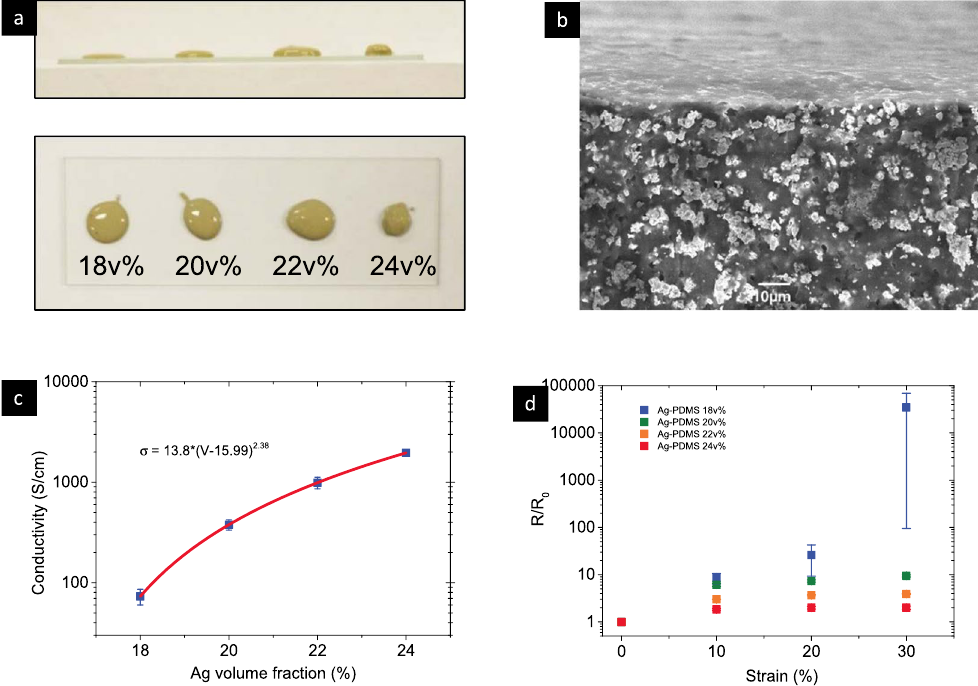
Figure 1. Electro-mechanical properties of different Ag-PDMS composites. ( a ) Ag-PDMS paste with different Ag volume fraction dropped on a glass sheet for 5 minutes; ( b ) cross section of 22 v% Ag-PDMS after curing; ( c